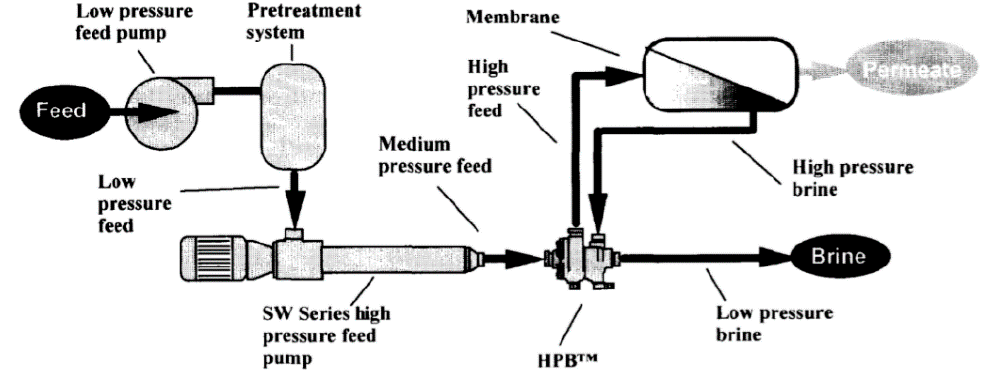
Figure 19. Component arrangement in a typical SWRO system [ Error! Reference source not found. ]. Table 7. A 120 ton/d example [ Error! Reference source not found. ].